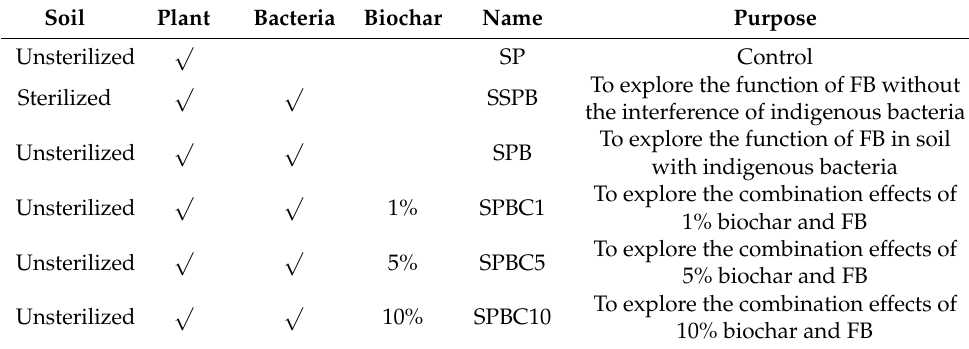
Table 3. Pot experimental design for different